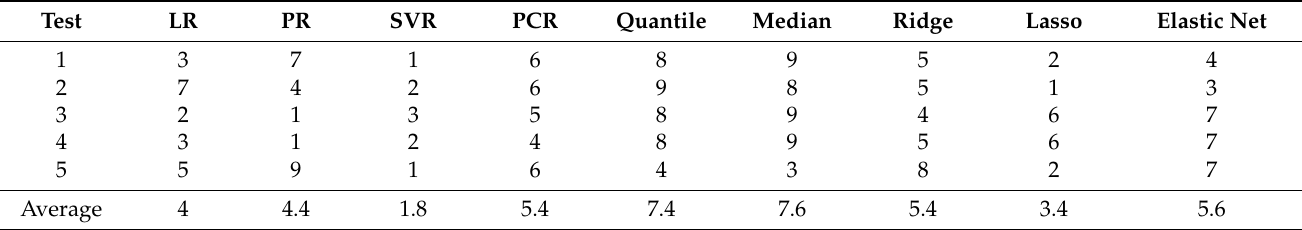
Table 5. Friedman ranks for Ra values in